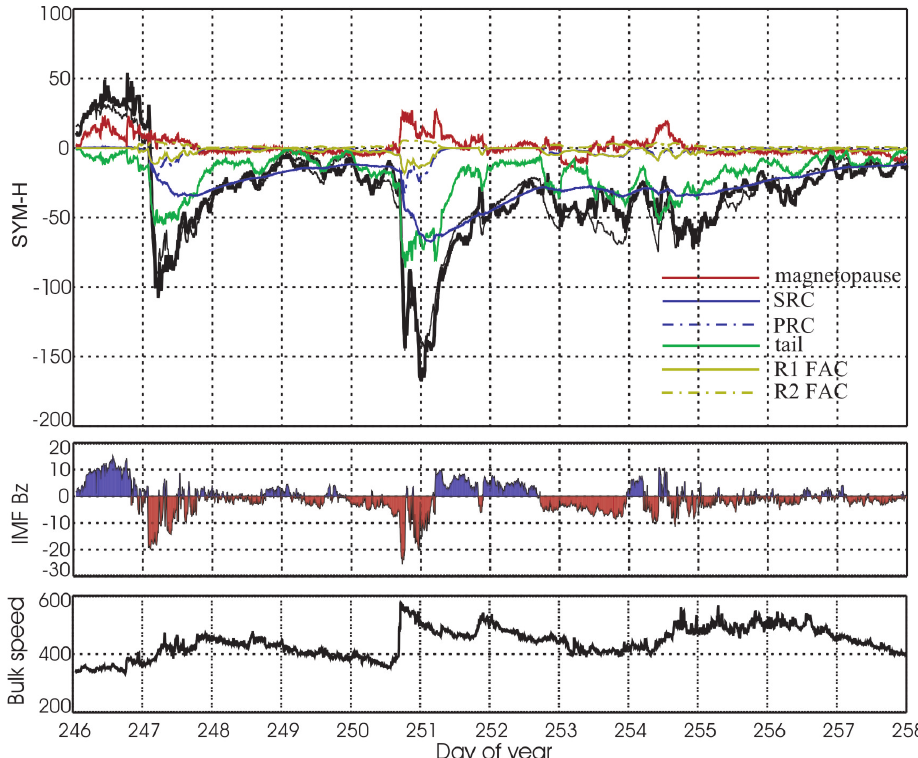
Fig. 11. Comparing the actual variation of the SYM-H index (heavy black line) during the storm of 3–14 September, 2002, with that calculated from the TS05 model (thin black line). Separate contributions from individual current systems are shown by coloured lines in the upper panel. Centre and bottom panels show the concurrent variation of IMF B z and the solar wind speed, respectively (Tsyganenko and Sitnov, 2005). were found to differ significantly from each other, from as large as ∼ 30 hours for the SRC to only ∼ 50 min for the R1 FACs. The total magnitude of the currents were also found to vary dramatically in the course of major events, with peak values as large as 5–8 MA for the SRC and R1 FACs. In line 805 with simulation results by Liemohn et al. (2001), at the peak of the main phase the total PRC can largely exceed the SRC, reaching 10 MA and even more, but it quickly subsides, as the external solar wind driving disappears, with the relaxation time less than 2 hours. The TC increases dramatically during the main phase and shifts earthward, so that the peak current concentrates at unusually close distances of 4–6 R E . 810